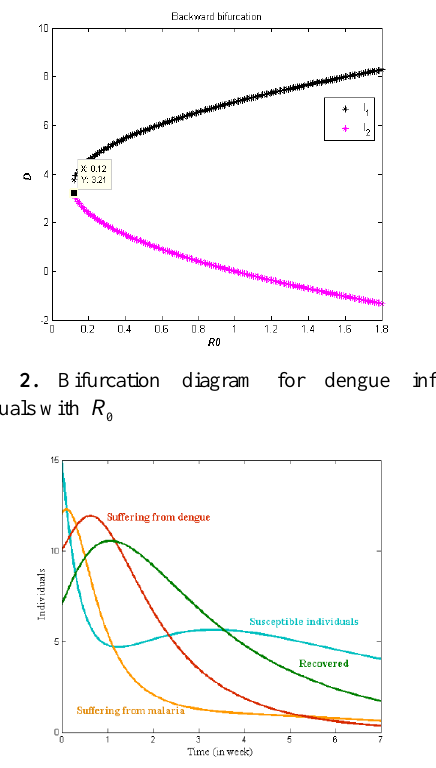
Figure 3. Time series of solution of malaria-dengue model